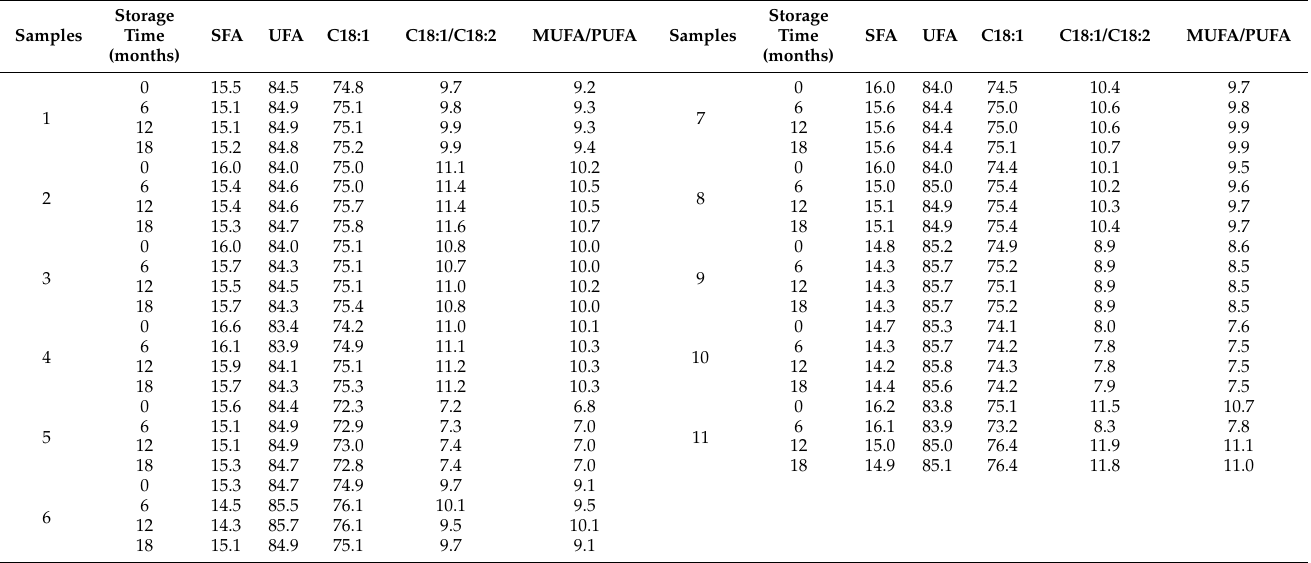
Table 1. %SFA, %UFA, C18:1 %FAME, C18:1/C18:2 and MUFA/PUFA ratio of VOOs cv. Chondrolia Chalkidikis and Chalkidiki from the main olive mills of the regional unit of Chalkidiki (2016/17).